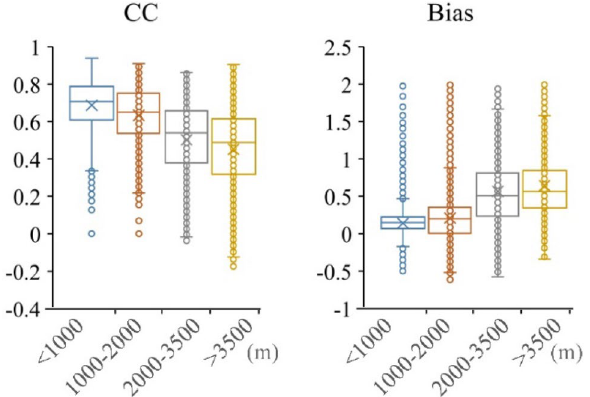
Figure 5. Box plots of CC and Bias between the ERA5 and observed annual precipitation data with different elevation during 1979–2018 in Chinese